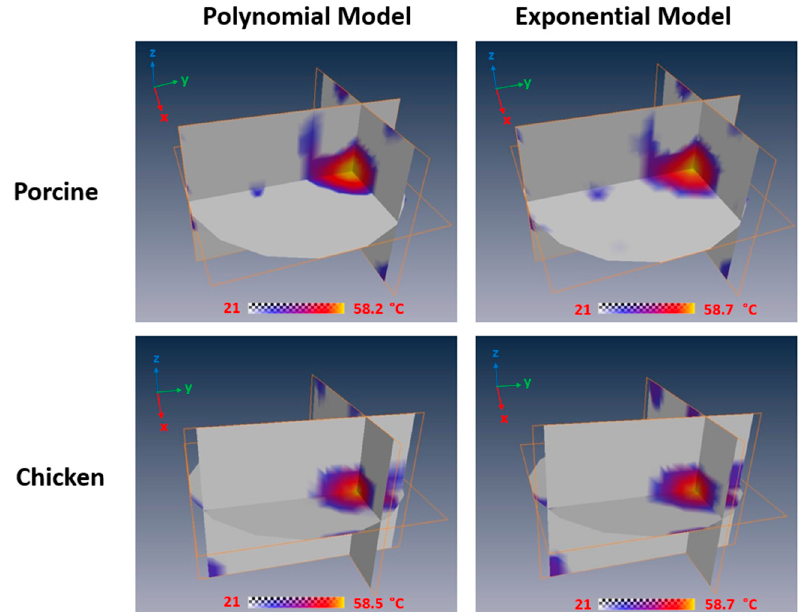
Figure 6. Temperature maps of porcine and chicken breast muscle at 10 min after HIFU treatment based on the polynomial model and exponential model.